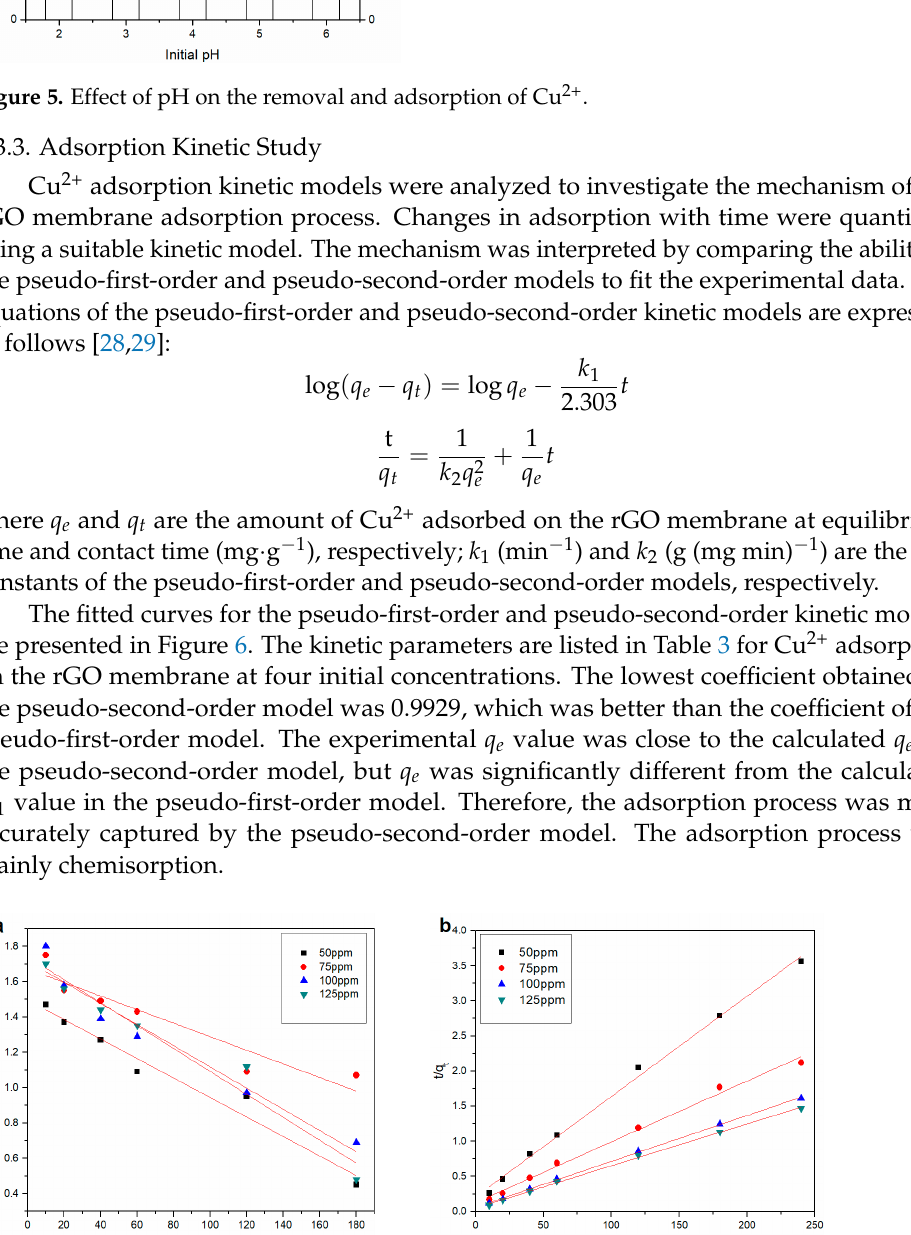
Figure 5. Effect of pH on the removal and adsorption of Cu 2+ .